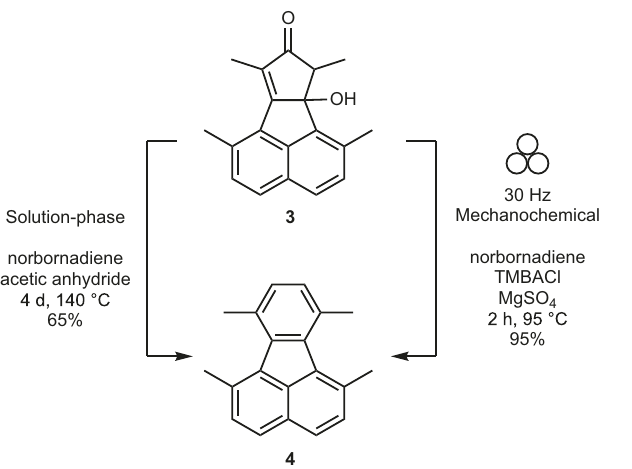
Fig. 3 Synthesis of 4. The solution-phase reaction was reproduced using the procedure provided in Butter fi eld et al. 55 .